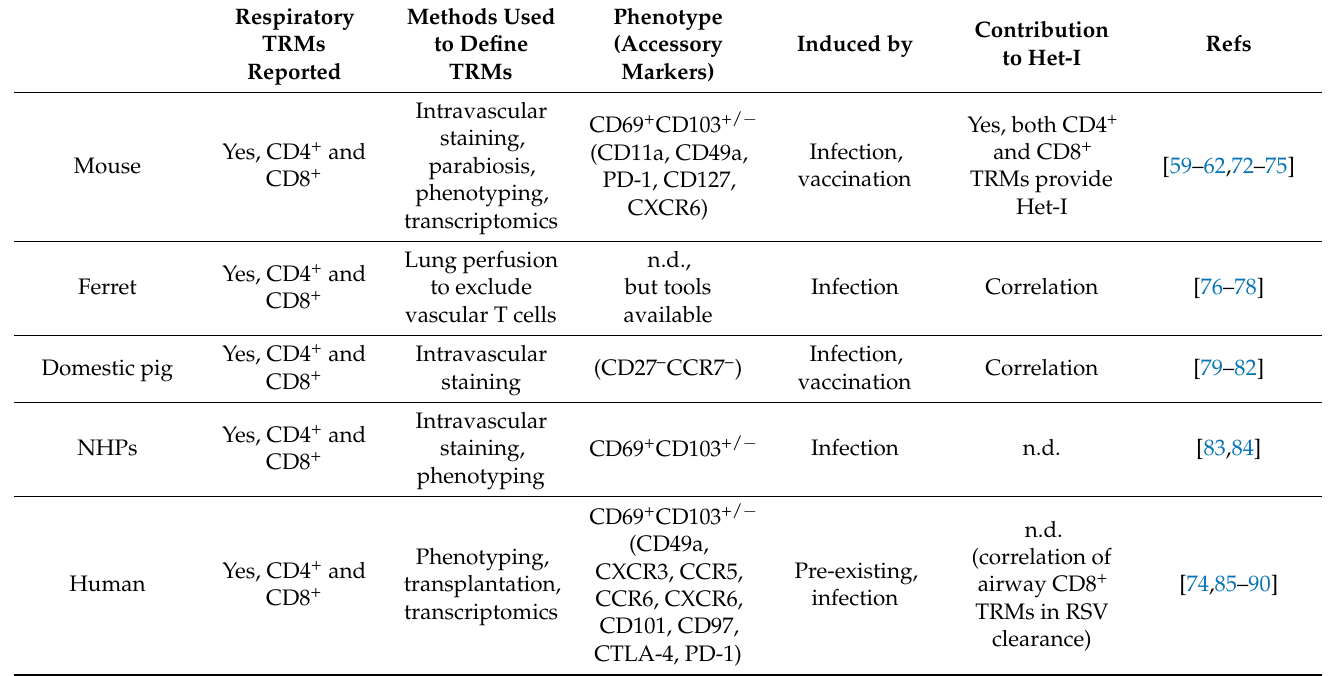
Table 1. Current knowledge about respiratory tissue-resident memory T cells (TRMs) in different